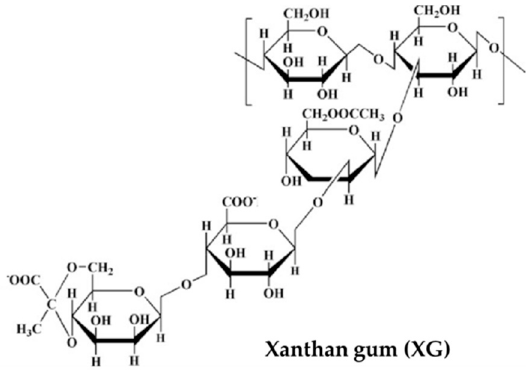
Figure 16. The structure of xanthan gum.